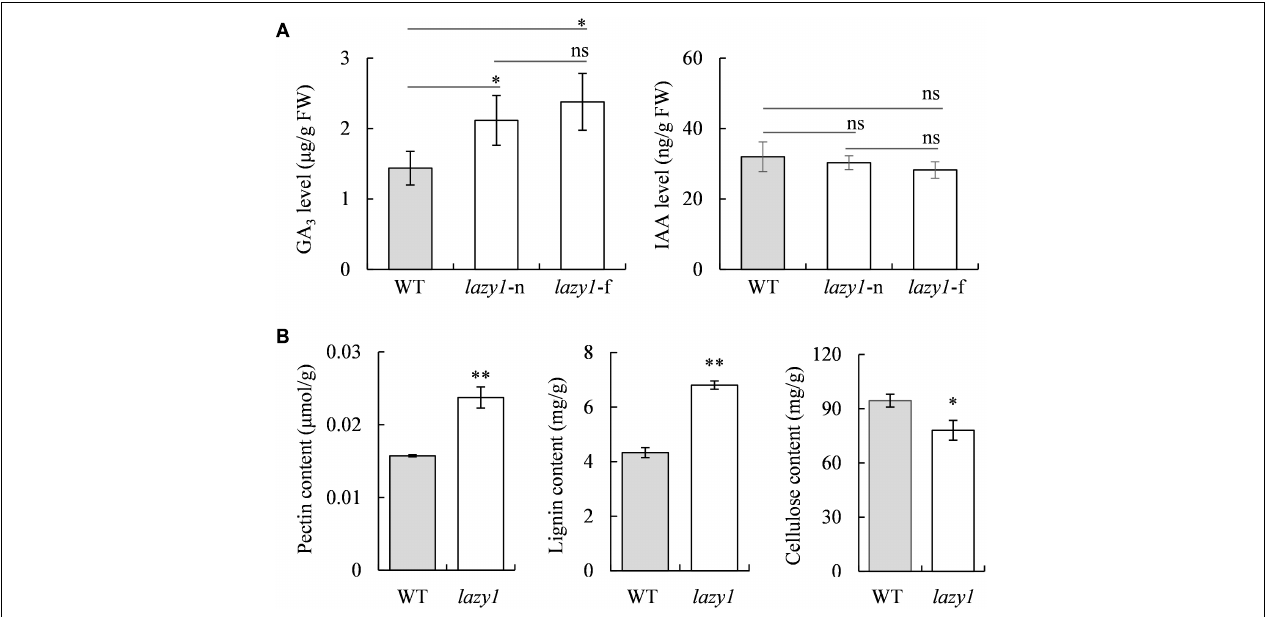
FIGURE 3 | Hormone levels and major cell wall structural components content of lazy1 bending stem. (A) The levels of GA 3 and IAA in near-ground ( lazy1 -n) and far-ground ( lazy1- f) side of lazy1 bending stem. (B) The contents of pectin, lignin and cellulose in lazy1 bending stem. Bars indicate standard deviation (SD, n = 4). “ns” indicates no significant difference. “ ∗ ” and “ ∗∗ ” indicate the significantly difference at 0.05 and 0.01 levels, respectively.